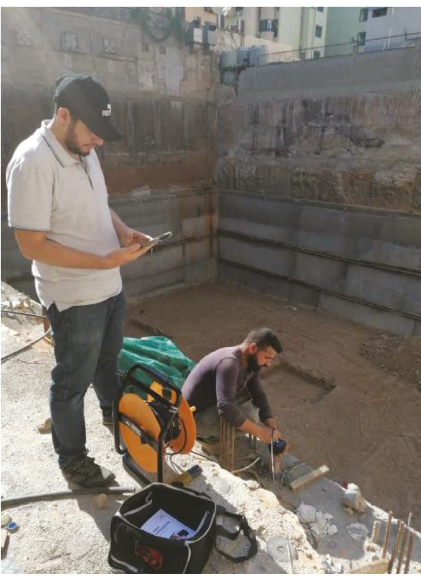
Figure 8: Taking inclinometer readings on-site.